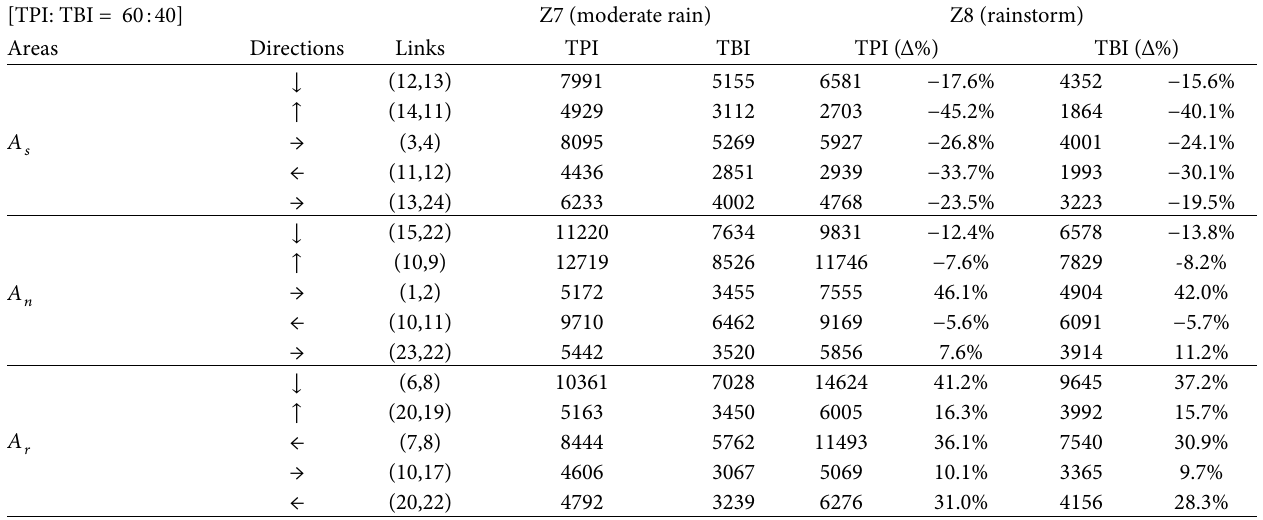
Table 11: The equilibrium flow patterns of TPI/TBI in Sioux Falls network in case Z7 and Z8.